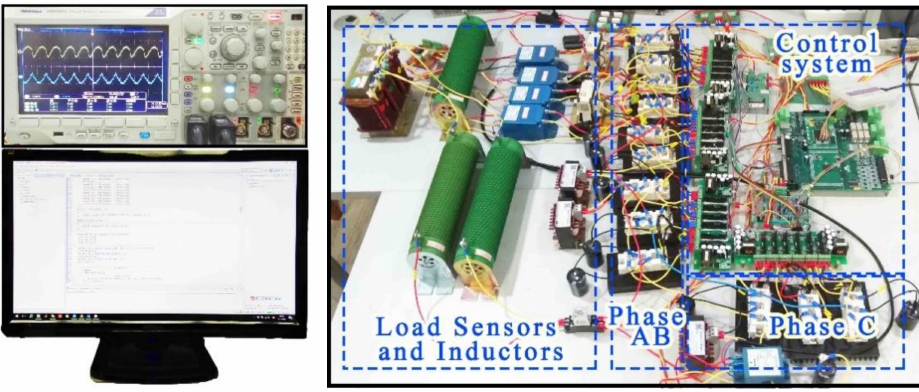
Figure 14. The physical map of the experimental system.